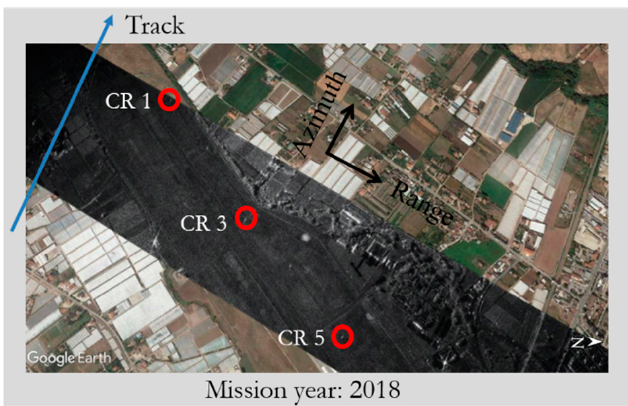
Figure 3. As Figure 2, but relevant to the Experiment 3. Number of exploited CRs (red circles): 3. Number of exploited tracks (blue line): 1. Mission year: